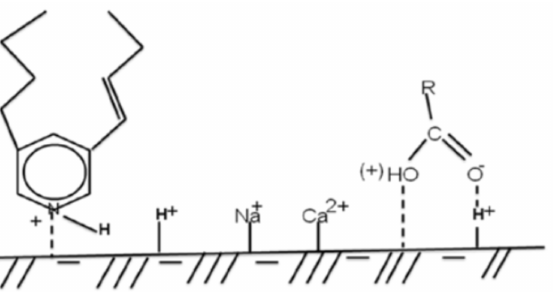
Figure 5. Active component ions on formation rock surface. Adapted from